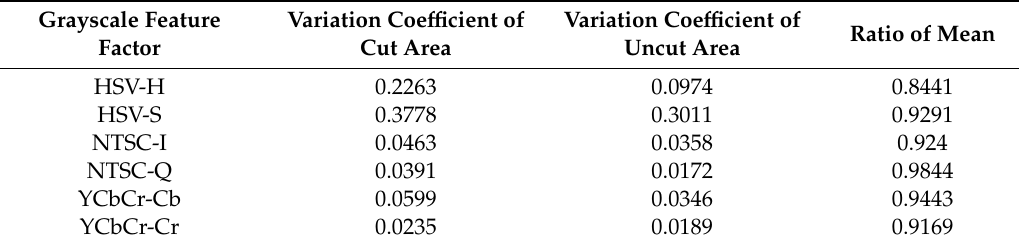
Table 2. Comparison of the different components.